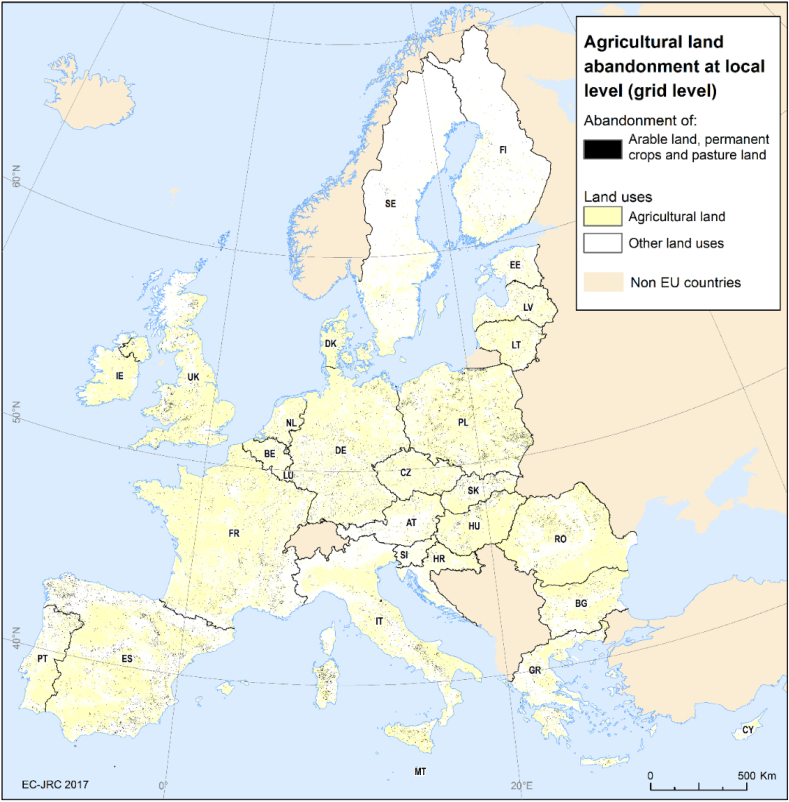
Future projections of agricultural land abandonment at grid level (100-m resolution) in the EU and the UK,2030.